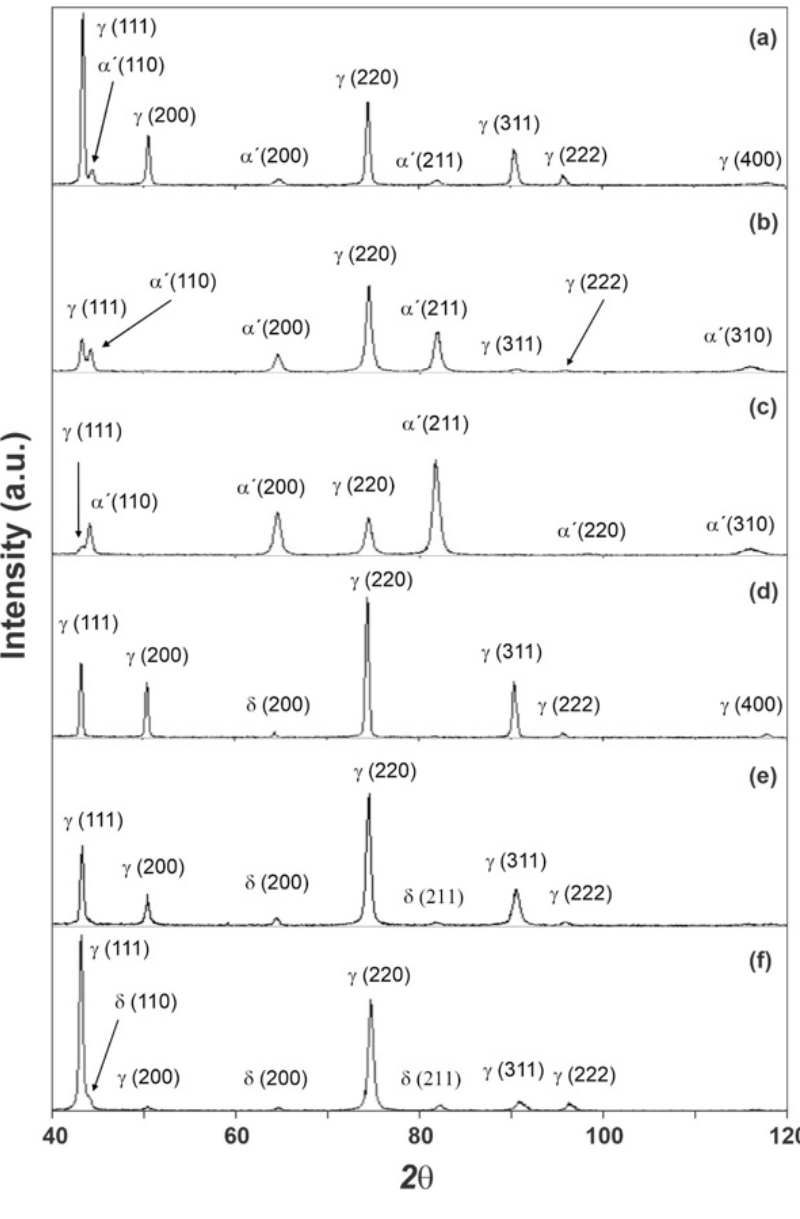
than the γ Table 5. Values of volumetric fraction, microstrain, and size of the crystalline domain obtained for all samples.